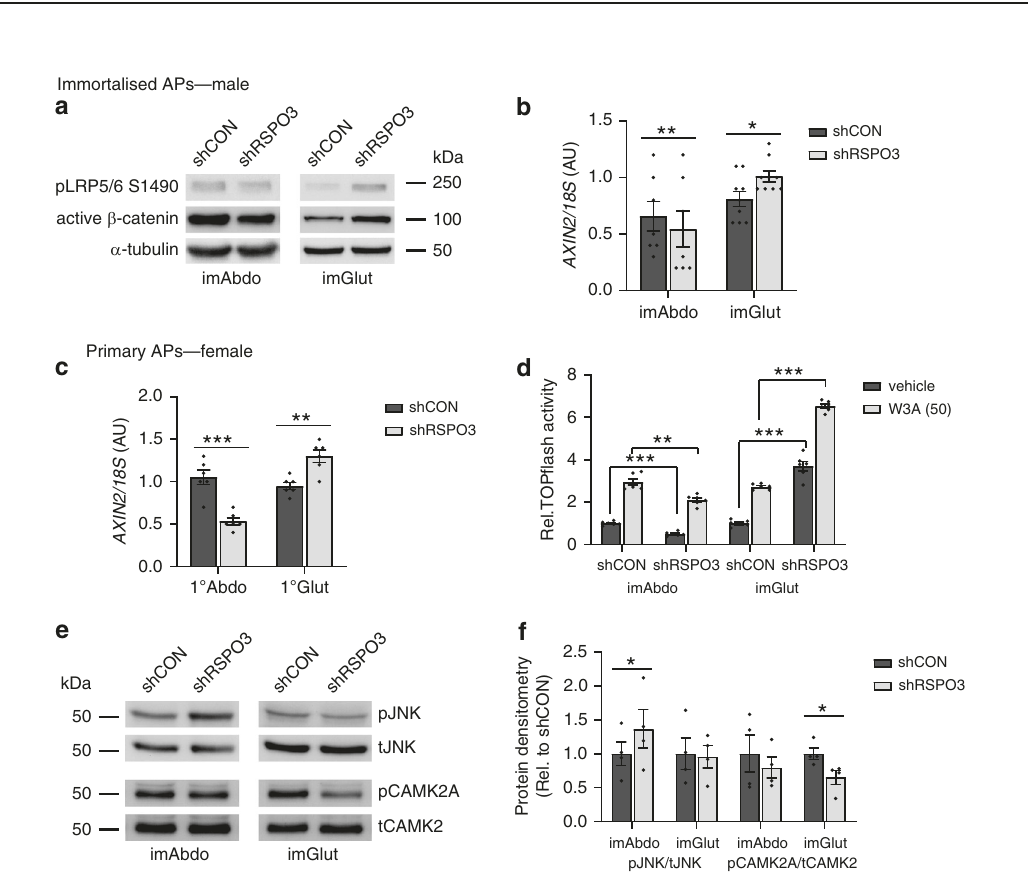
Fig. 5 Effects of RSPO3 -KD on canonical and non-canonical WNT signalling in SC abdominal and gluteal APs. a Western blots of canonical WNT signalling markers and b qRT-PCR of AXIN2, a WNT/ β -catenin target gene, in control (shCON) and RSPO3-KD (shRSPO3) imAbdo ( n = 7 experiments) and imGlut APs ( n = 9 experiments). c qRT-PCR of AXIN2 in shCON and shRSPO3 1° APs. d RSPO3-KD in imAbdo versus imGlut cells has differential effects on TOP fl ash promoter activity [W3A (50), 20-h treatment with 50 ng ml -1 rhWNT3A] ( n = 6 replicates/treatment). e Western blots of non- canonical WNT signalling markers in shCON and shRSPO3 imAbdo and imGlut APs. f Protein densitometry for pJNK/tJNK and pCAMK2A/tCAMK2 are shown relative to shCON levels. n = 4 independent experiments. Histogram data are means ± s.e.m. * p < 0.05, ** p < 0.01, *** p < 0.001.